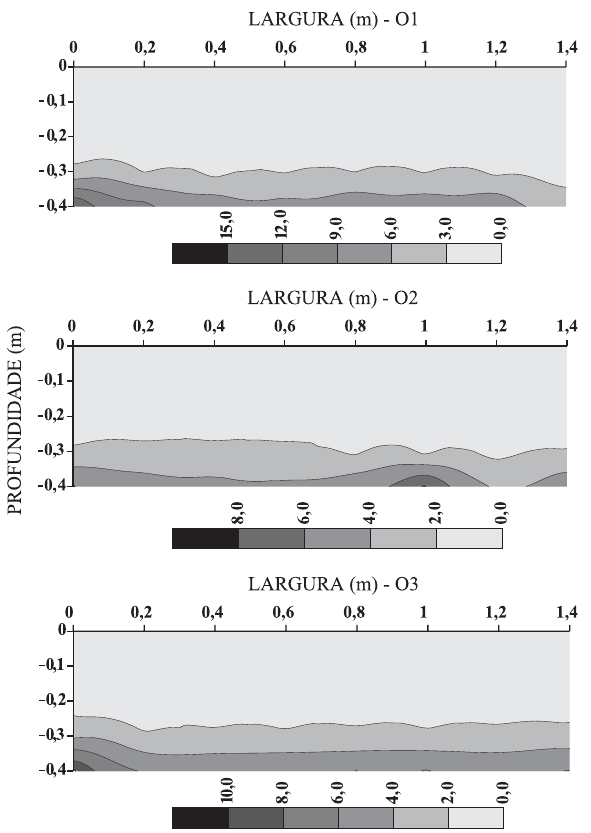
Figura 5. Mapa de isolinhas do atributo RP (MPa) no perfil do solo preparado com uma (O1), duas (O2) e três (O3) operações da grade leve off-set com discos de 0,61 m de